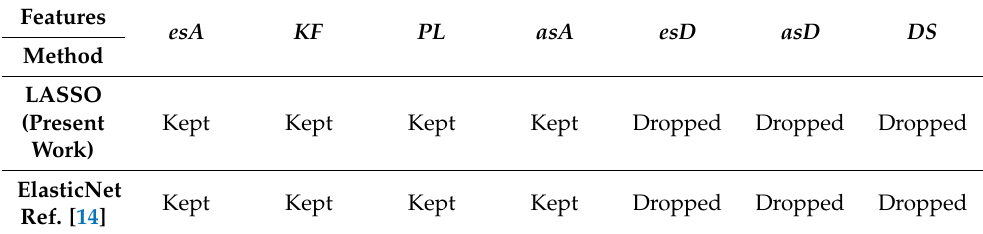
Table 1. LASSO and ElasticNet feature selection decision.